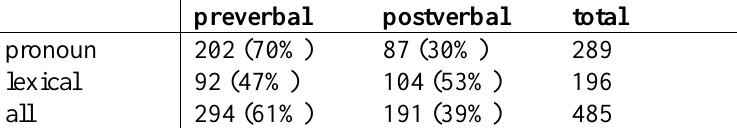
Table 4. Subject-verb inversion and type of subject preverbal